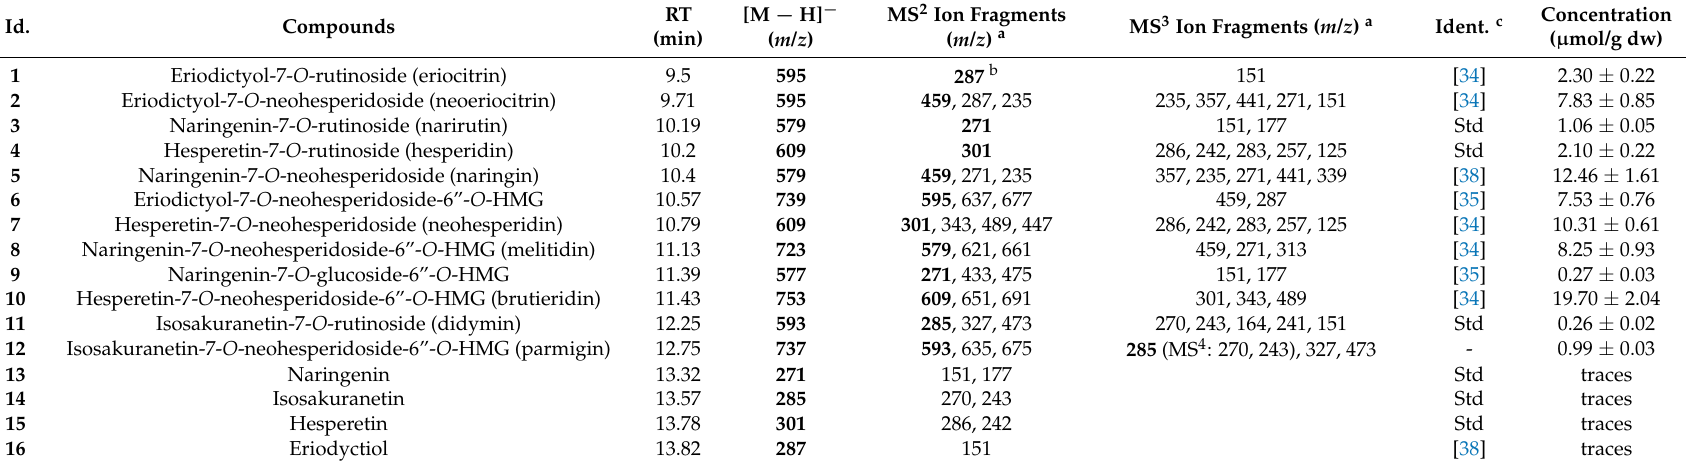
Table 1. Flavanone compounds in bergamot